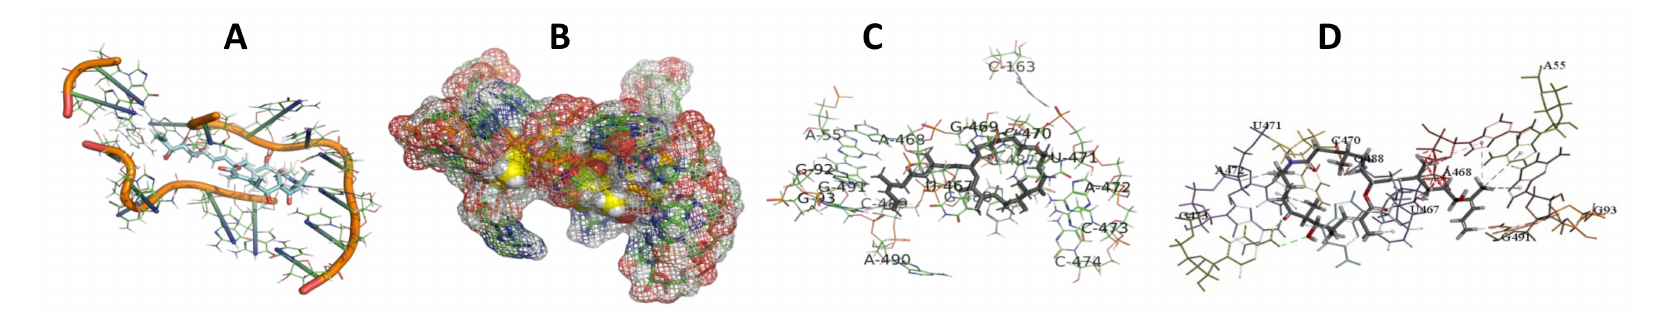
Figure 6. L. Major bound to Angiolam. ( A ): Best binding pose and nucleotides involved. ( B ): Schematic binding pocket. ( C ): shows the Nucleotides component that re involved in binding. ( D ): Shows the main bonds involved between the compound and the nucleotide component.